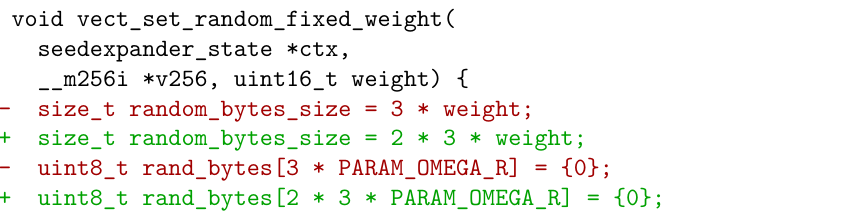
Figure 8: Patch to HQC to remove additional seedexpander calls